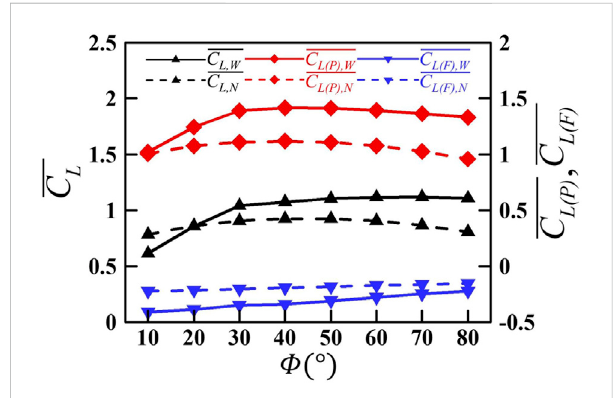
FIGURE 8 Variation in the mean lift and the pressure- and friction-based lift of the wing as a function of the fl apping amplitude Φ with/without wake effect. Subscripts “ P ” and “ F ” in the symbols represent the pressure-andfriction-basedcomponentsofthelift,respectively. Subscripts “ W ” and “ N ” in the symbols represent the cases with and without wake effect, respectively.